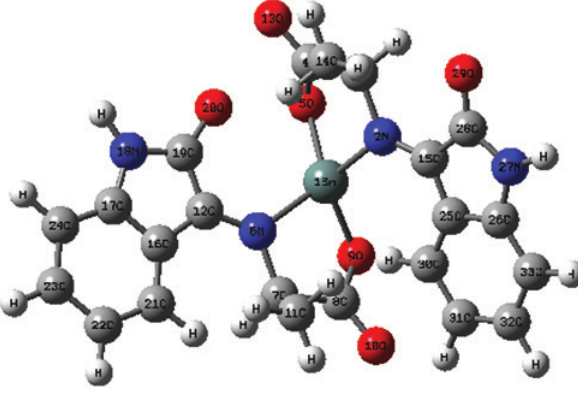
Figure 2: B3YLP/LanL2DL optimized geometry for the